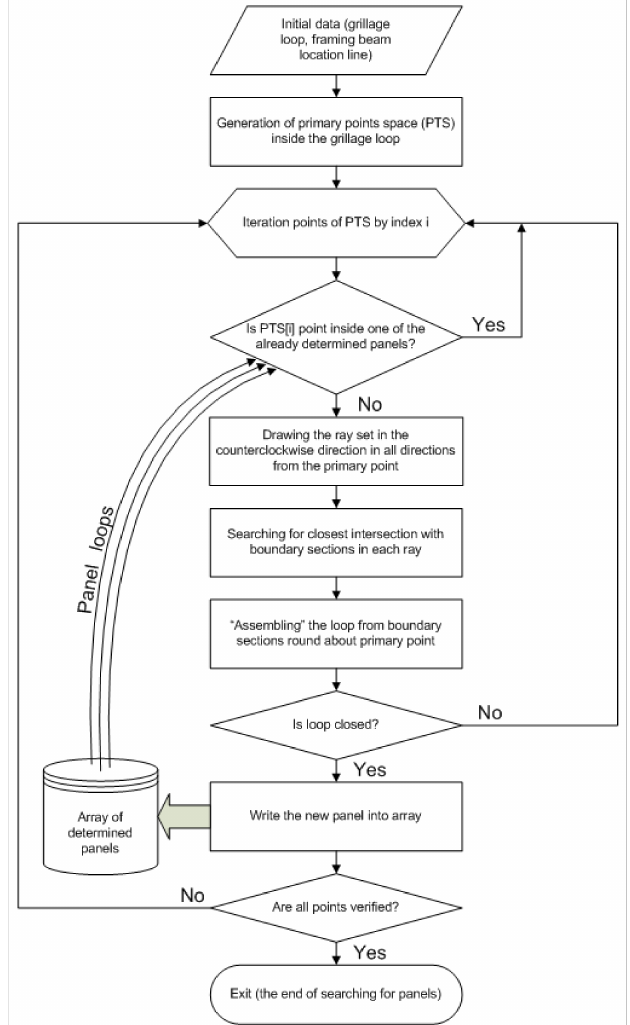
Figure 8. An algorithm for panels searching for a structure (shell expansion) with a supporting structure of arbitrary shape.